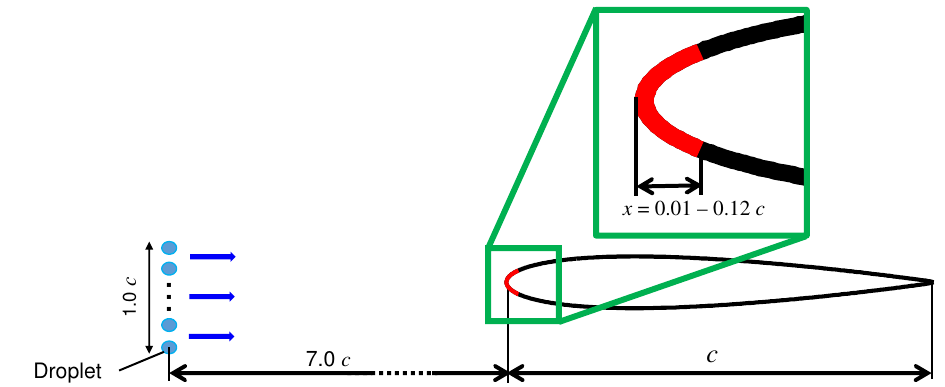
Figure 6. Schematics of the initial droplet location and heating area. The red region on the airfoil indicates the heater setting